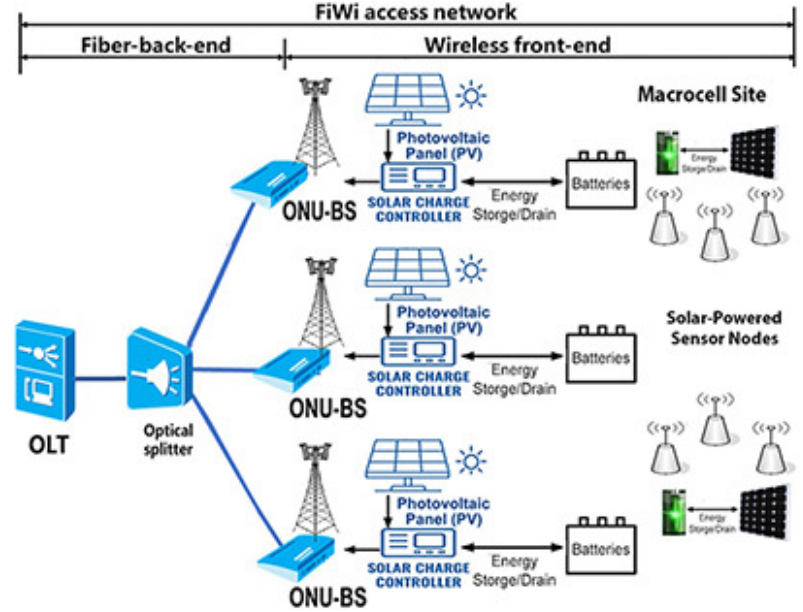
Figure 1. Solar-powered PON-based FiWi network